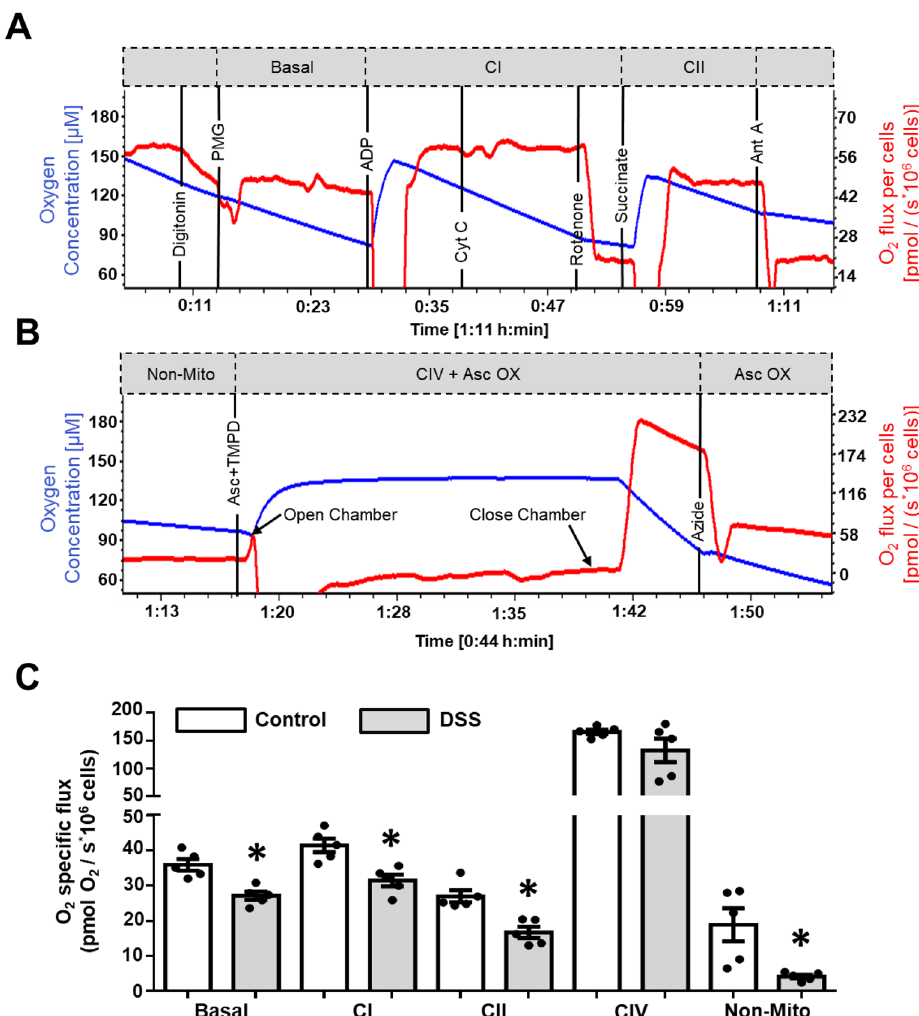
Figure 2. Results of Oroboros O2k for IEC 4.1 ± 2% DSS 24 h treatments using the mitochondrial-specific complex protocol. ( A , B ) Oroboros O2k representative tracings of control IEC 4.1 cells. ( C ) Mitochondrial-specific O 2 flux during basal, mitochondrial complex linked (CI, CII, CIV) non-mitochondrial respiration (non-mito). Black vertical lines indicate additions of substrates/inhibitors/uncouplers., PMG: pyruvate (5 mM) + malate (2 mM) + glutamate (10 mM), ADP: adenosine diphosphate (2.5 mM), Cyt C: cytochrome c (10 µM), Rot: rotenone (0.5 µM), Succinate (10 mM), Ant A: antimycin A (2.5 µM), Asc + TMPD: ascorbate (2 mM) + TMPD (0.5 mM), Azide: sodium azide (≥ 100 mM). Gray hatched boxes represent different respiratory states: basal, complex I (CI), complex II (CII), non-mitochondrial respiration (Non-mito), and CIV + Asc Ox/Asc Ox (CIV). Data is presented as mean ± SEM (n = 5 replicates from 3 independent experiments; *Represents significant differences between the control group, p < 0.05; two-tailed independent t-tests for each respiratory